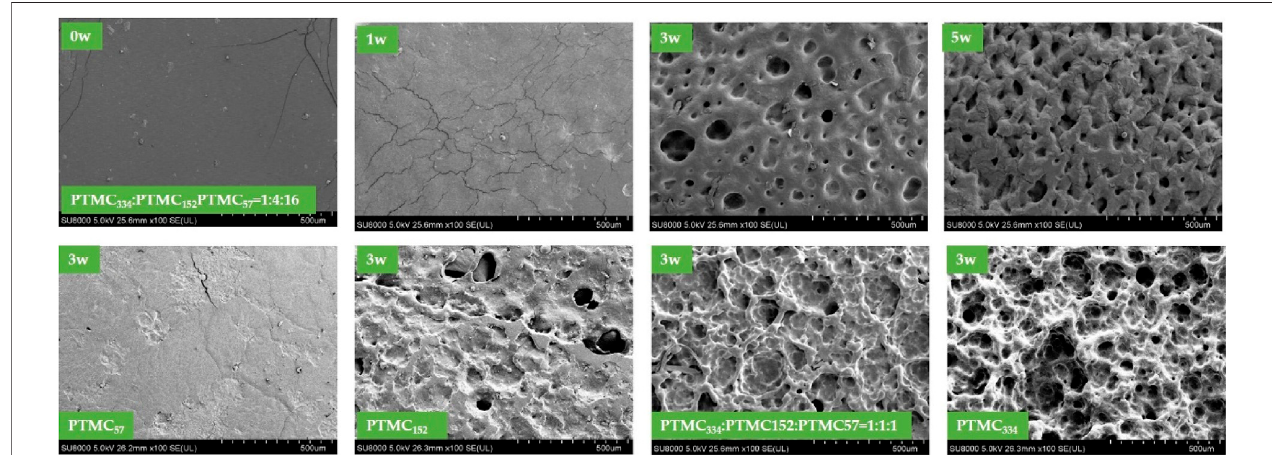
FIGURE 3 | The surface morphology of PTMC fi lms and the ternary self-blending fi lms after degradation in lipase solutions.